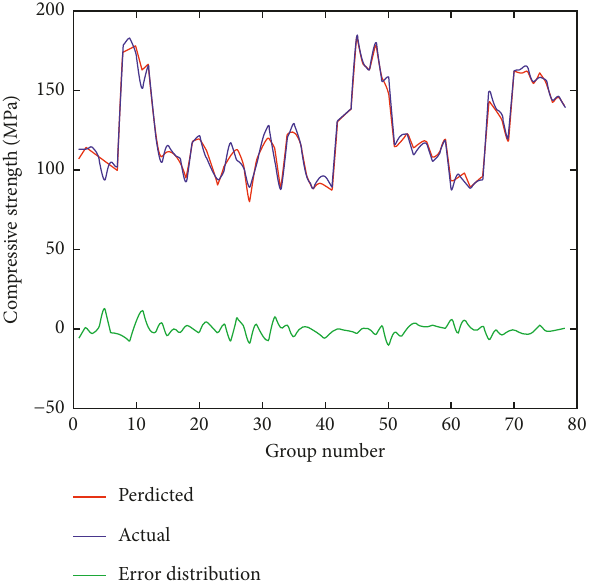
Figure 6: Evaluation of the actual value and predicted